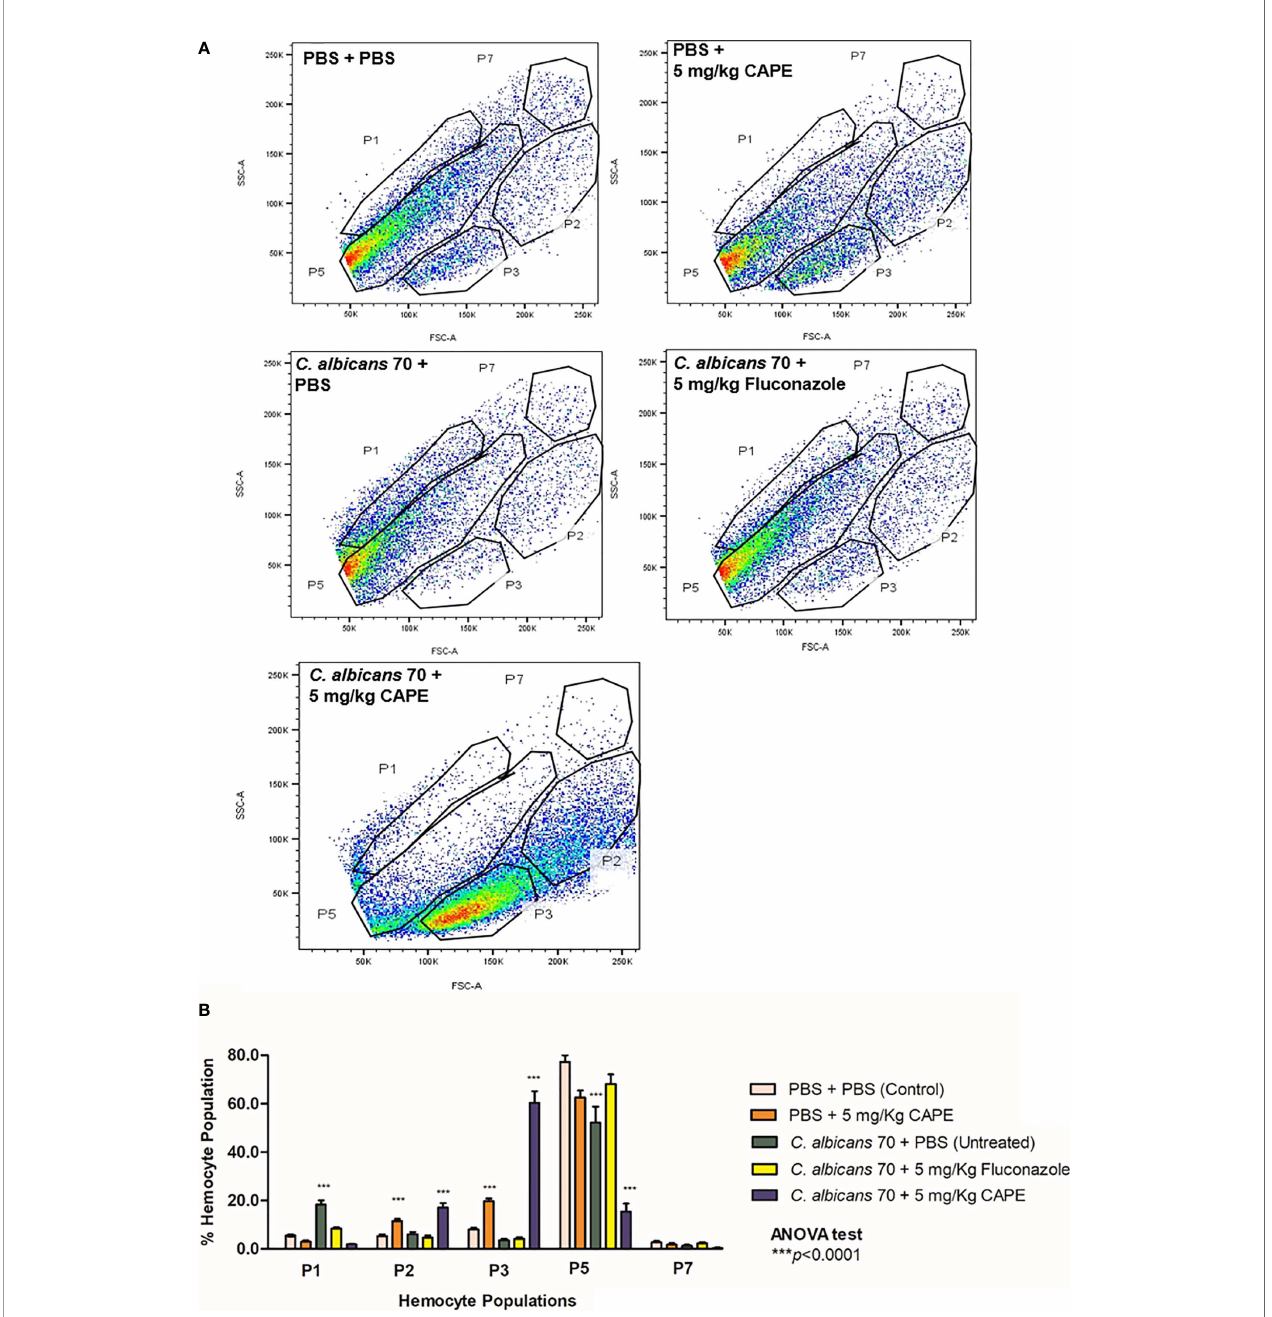
FIGURE 6 | FACS analysis of larval hemocyte population. (A) Hemocytes were extracted from larvae and differentiated by FACS based on cell size (x-axis) and granularity (y-axis). Representative images of hemocytes in the P1, P2, P3, P5, and P7 sub-populations are presented in each group. (B) Fluctuations in hemocyte sub-populations in larvae for the control group (PBS), group infected only CA70 (untreated) and groups infected and treated with fl uconazole and CAPE (5 mg/Kg). The relative proportion of hemocyte sub-populations in larvae was measured by FACS analysis ( p is relative to the hemocyte sub-population in the control (PBS) in relation to others groups). ANOVA test (*** p <